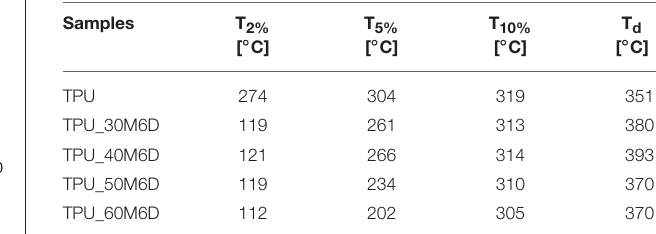
TABLE 3 | Results of thermogravimetric test on neat TPU and relative